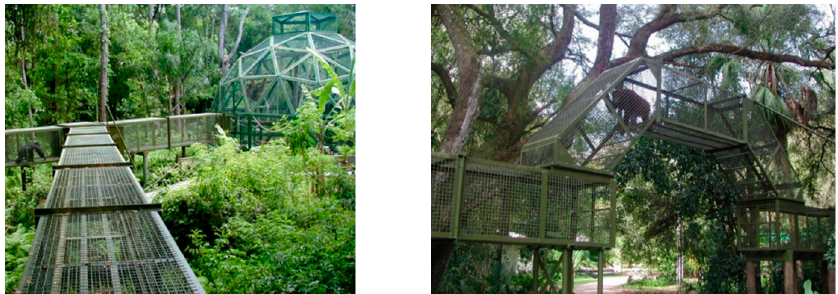
Figure 6. Elevated animal rotation raceways or “trails” developed at the Center for Great Apes in Wauchula, Florida (Photos: Center for Great Apes).